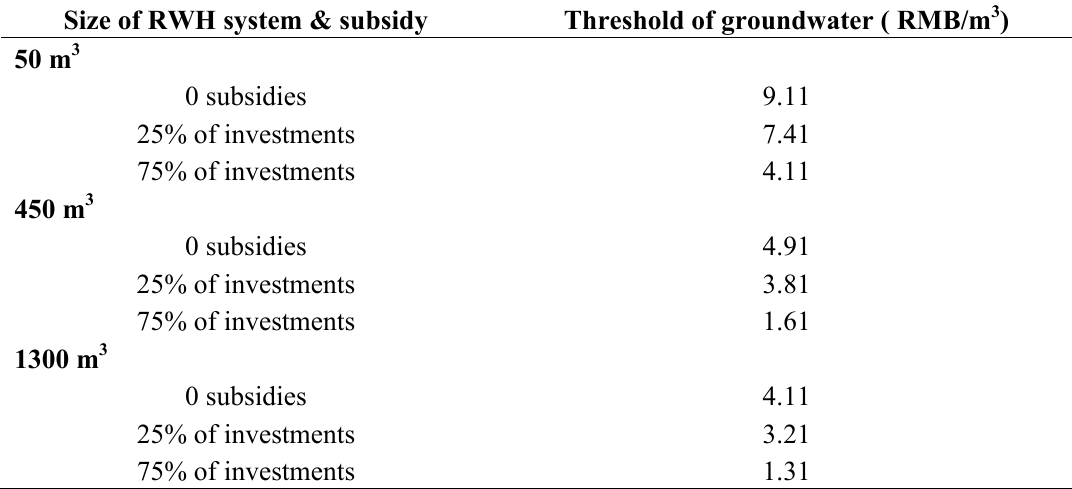
Table 4. Threshold values of groundwater for different sizes and subsidy levels for RWH